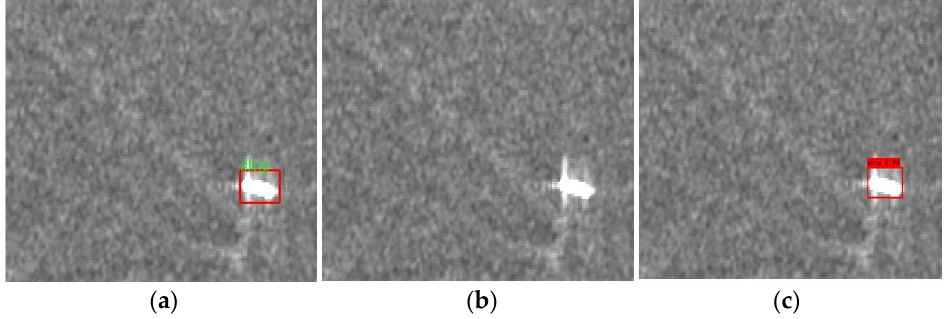
Figure 15. Ship detection is affected by high noise in SAR images. ( a ) Correct position of the ship in the SAR image; ( b ) Ship detection effect of YOLO V5 in SAR images; ( c ) Ship detection effect of FLNet in SAR images.